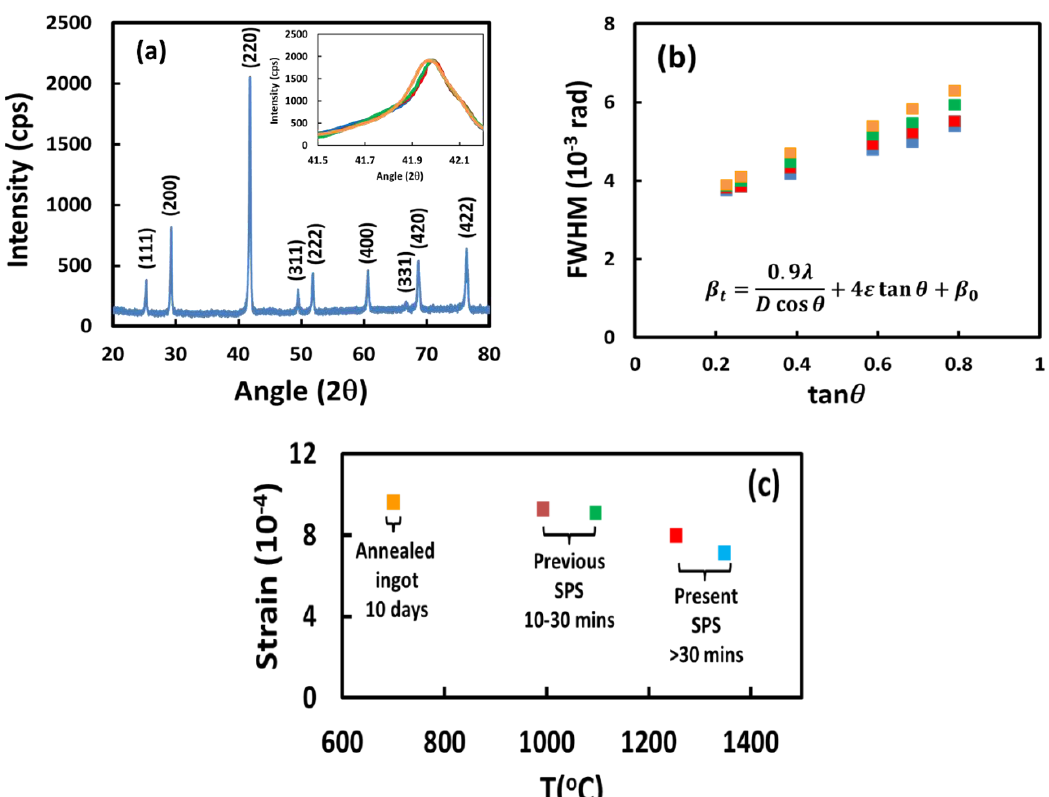
Figure 3. ( a ) X-ray pattern for Hf 0.6 Zr 0.4 NiSn 0.995 Sb 0.005 . Inset: (220)-reflection profile for samples produced by spark plasma sintering (SPS) at 1350 (blue), 1250 (red), and 1100 ◦ C (green), and as cast ingot annealed at 700 ◦ C for 10 days (orange). ( b ) Full width at half maximum (FWHM) of six strong and medium reflections (size of symbols represents uncertainty). Peak-broadening β t is due to contributions from average particle size ( D ), strain ε , and instrumental broadening β o . Since D >> λ , the first term can be neglected. ( c ) Strain vs. processing temperature for SPSed and conventionally annealed samples. The data point for a sample produced by SPS at 1000 ◦ C (brown) is also included. X-ray results for this sample are not shown in ( a , b ) to reduce overlapping data.